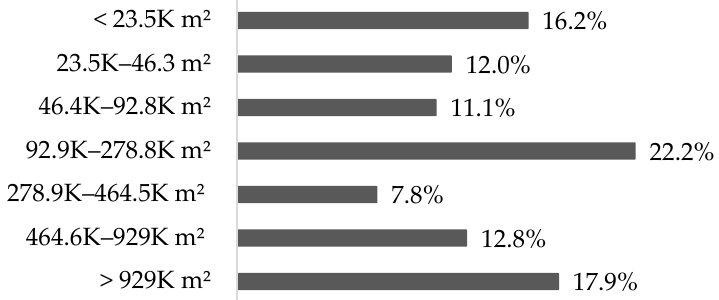
Figure 4. Total gross square meter (m 2 ) served by the participants’ FM departments.